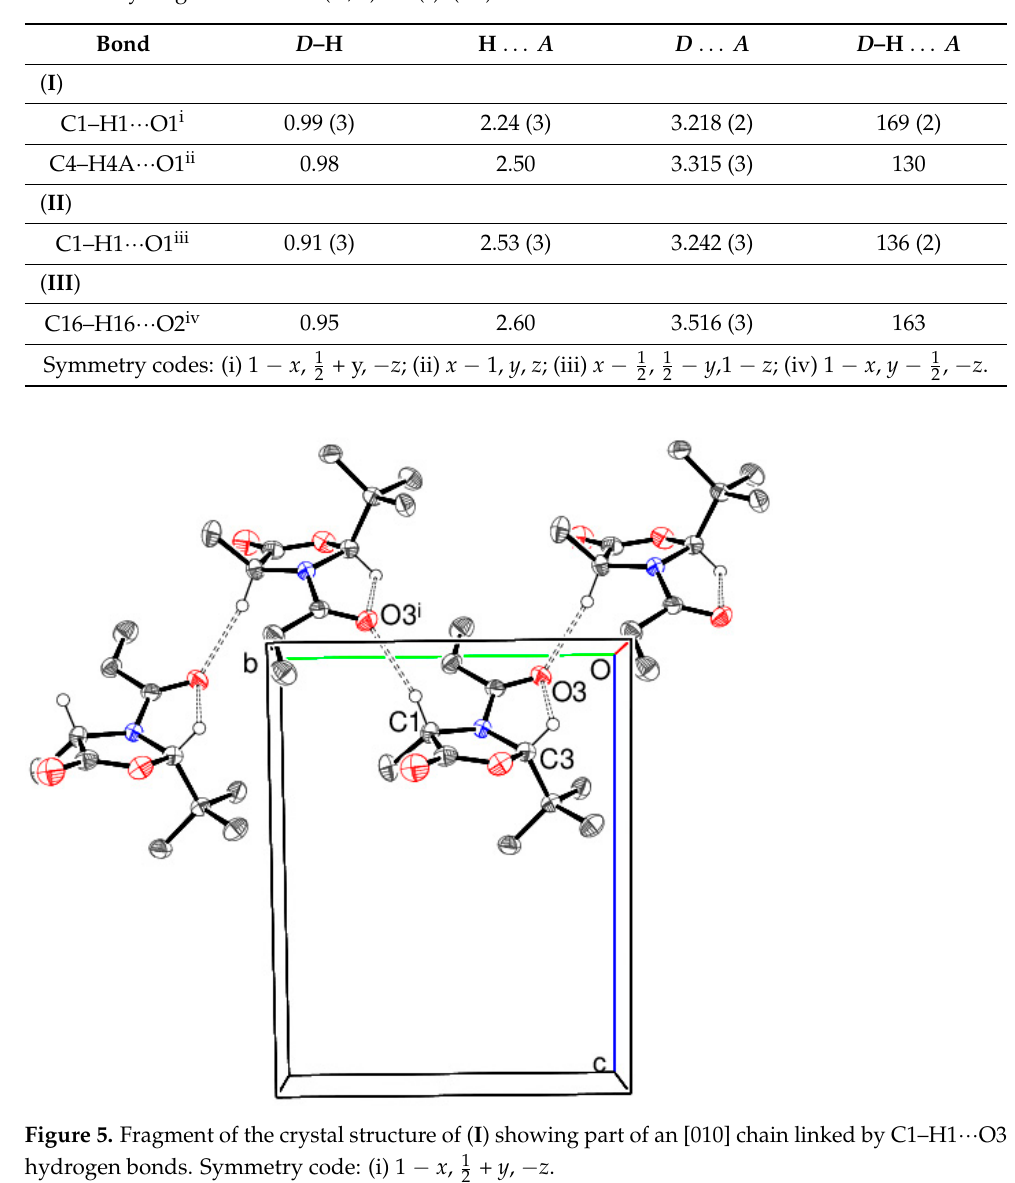
Figure 6. fragment of the crystal structure of ( II ) showing part of a [100] chain linked by C1–H1···O3 hydrogen bonds. Symmetry code: (i) x − ½, ½ − y , 1 − z .